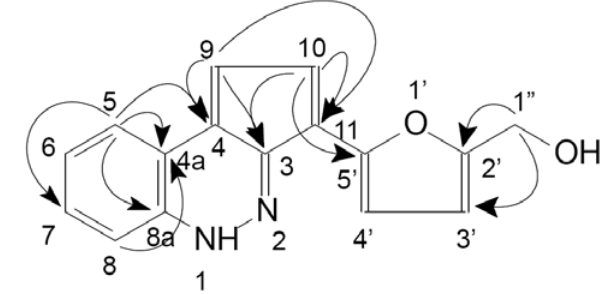
Figure 4. Chemical structure and key HMBC correlations (H → C) of compound 1 (2-furanmethanol-(5' →